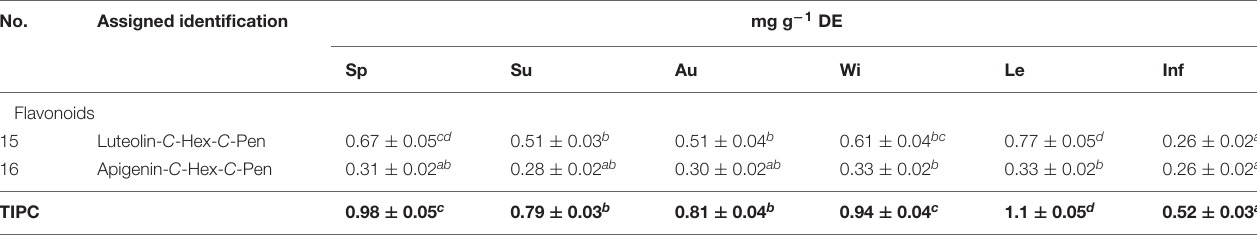
DE, dry extract; Sp, spring; Su, summer; Au, autumn; Wi, winter; Le, leaves; Inf, inflorescences. Bold values represent the sum of each type of components. TIPC, total individual phenolic content (sum of all compounds quantified individually). Different superscript letters correspond to significant differences between seasons and plant organs (p <